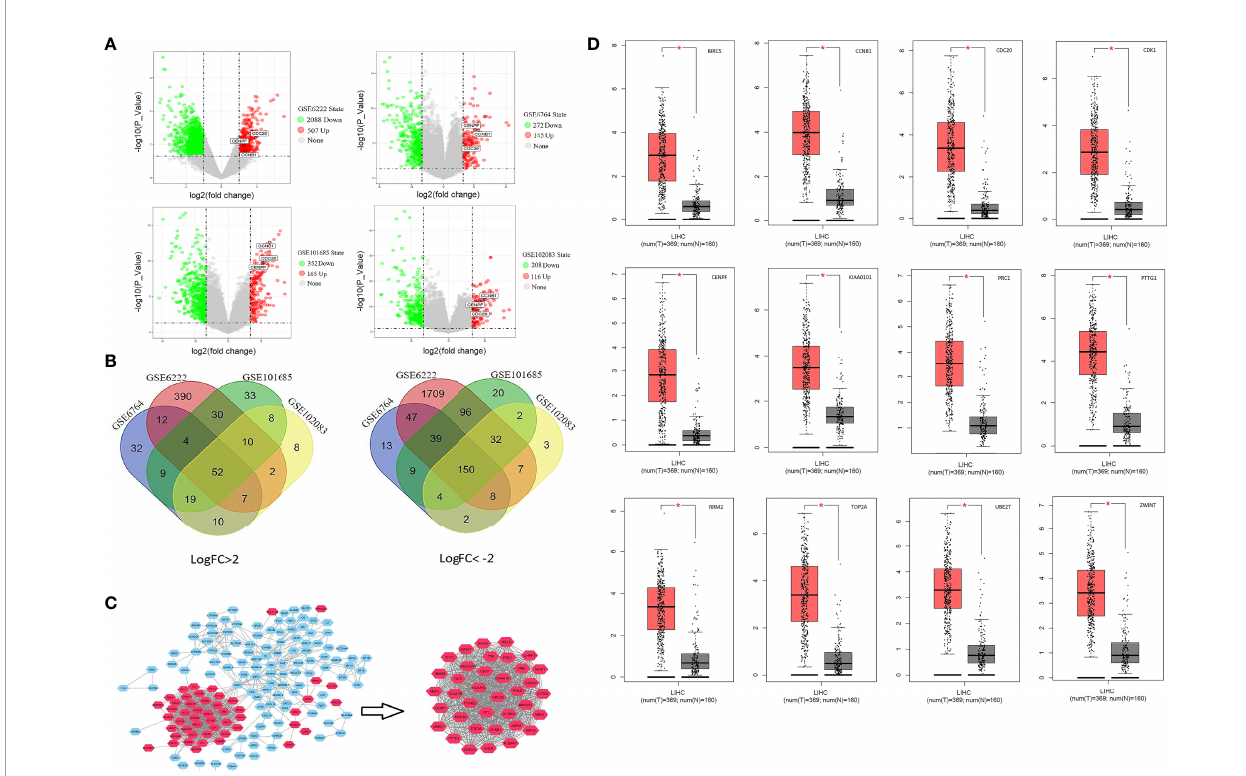
FIGURE 1 | Identify central cluster and gene expression validation: (A) Volcano plots of differentially expressed genes. (B) Venn Diagram of commonly up-/ downregulated genes. (C) Screening of central cluster using MCODE plug-in. (D) Validation of central cluster genes expression in LIHC (liver hepatocellular carcinoma); red boxplot represents HCC tissue, and black box represents normal liver tissue. * P < 0.05.